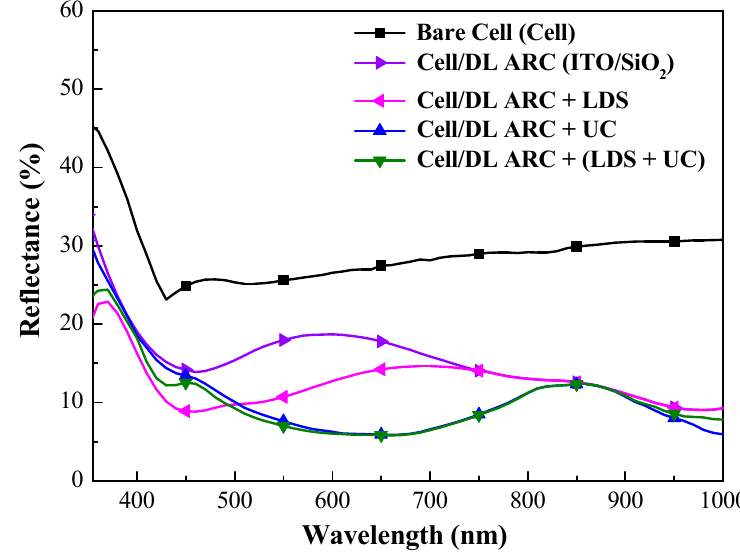
Figure 11. Optical reflectance spectra of bare-type GaAs single-junction solar cell (hereafter referred to as cell), cell/DL-ARC, cell/DL-ARC + LDS, cell/DL-ARC + UC, and cell/DL-ARC + (LDS + UC). Nanomaterials 2019 , 9 , x FOR PEER REVIEW